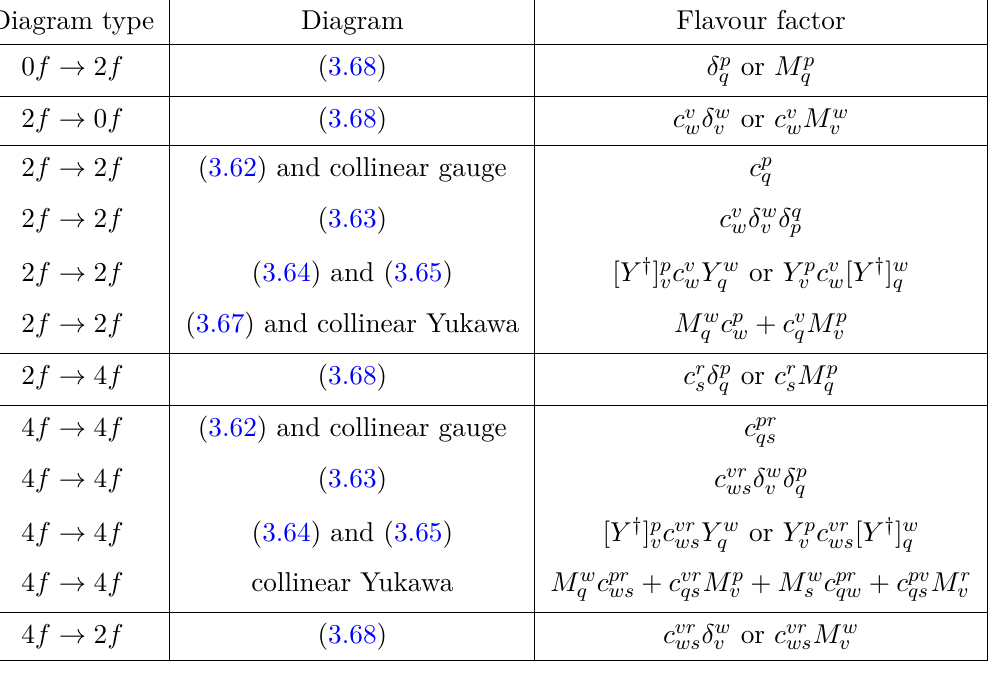
Flavour factors that appear in contributions to the anomalous dimension